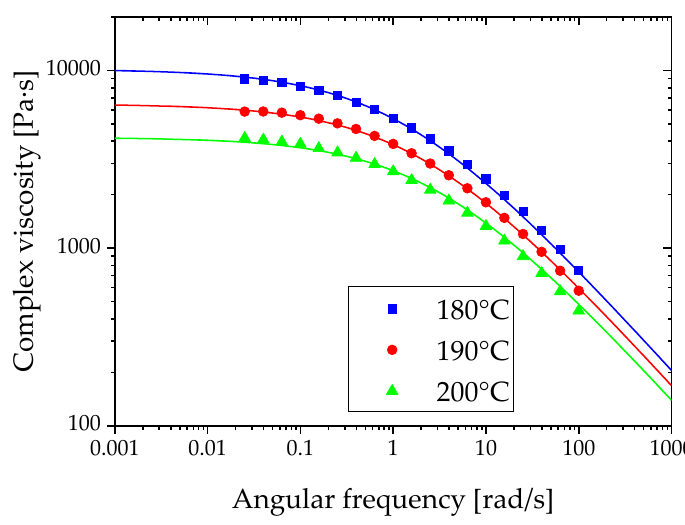
Figure 4. Viscosity data and curves obtained using the Cross model.